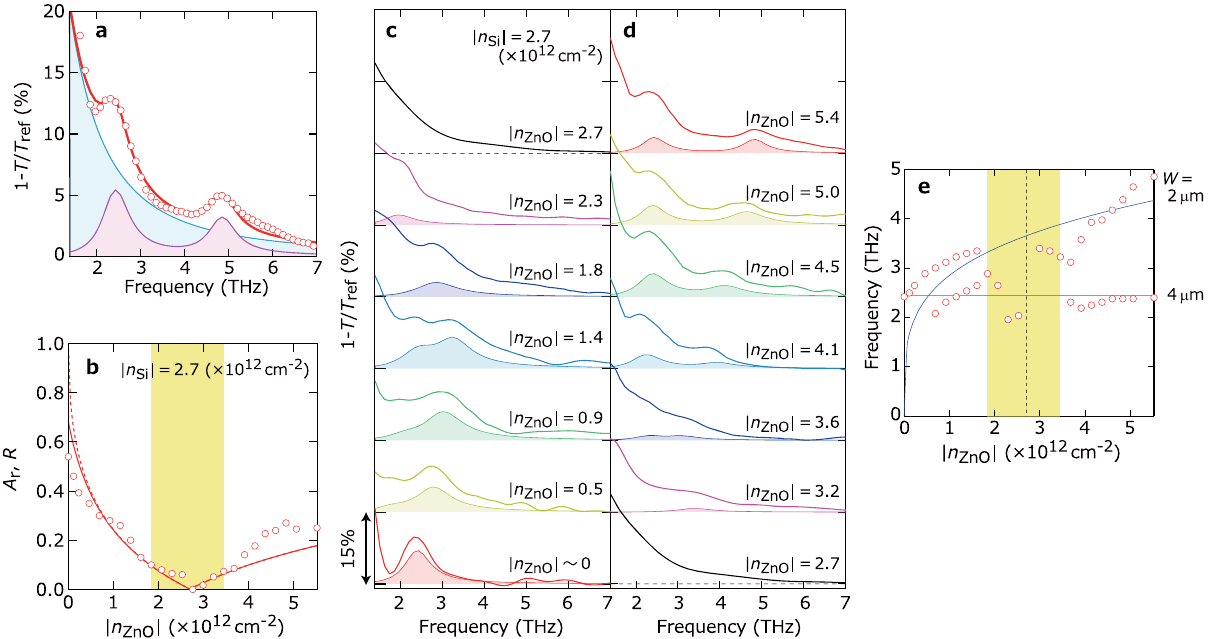
j j ¼ 2 : 7 ´ 10 12 cm (cid:2) 2 with fi tting line based on Si j (cid:5) j n j and ZnO Si ZnO |. Red and